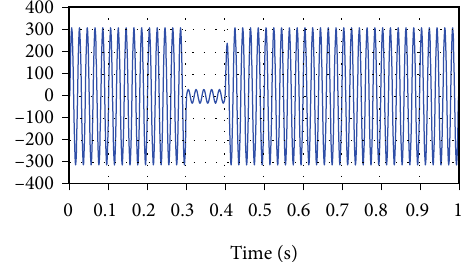
Figure 9: A sag in the grid voltage estimated ̂ x